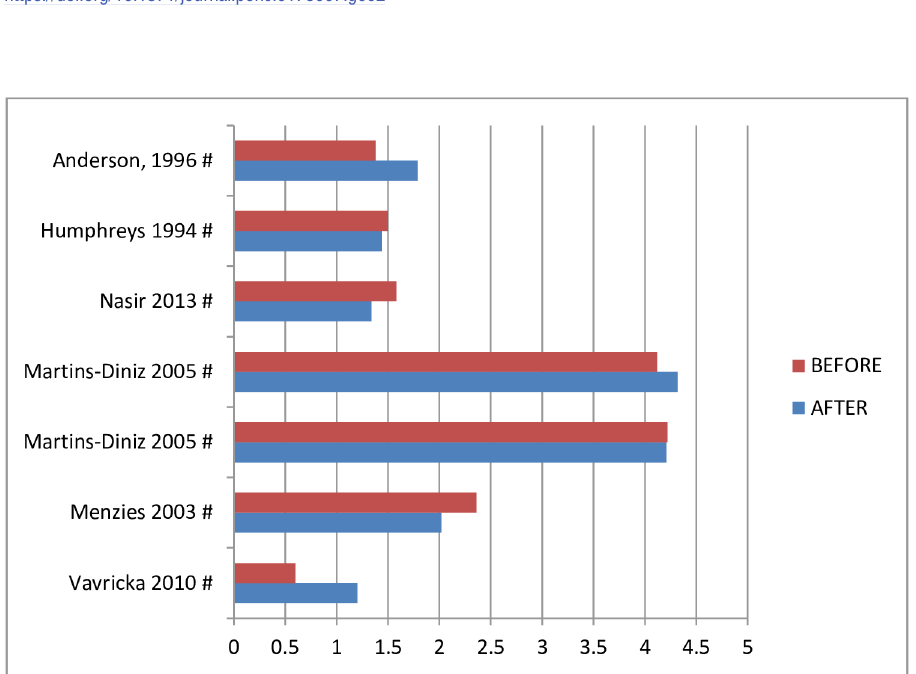
Fig 3. Bacterial or fungal loads in mean Log-10 CFU/m 3 in hospitals, measuredtwice. * = passive samplingmethod; # active samplingmethod.